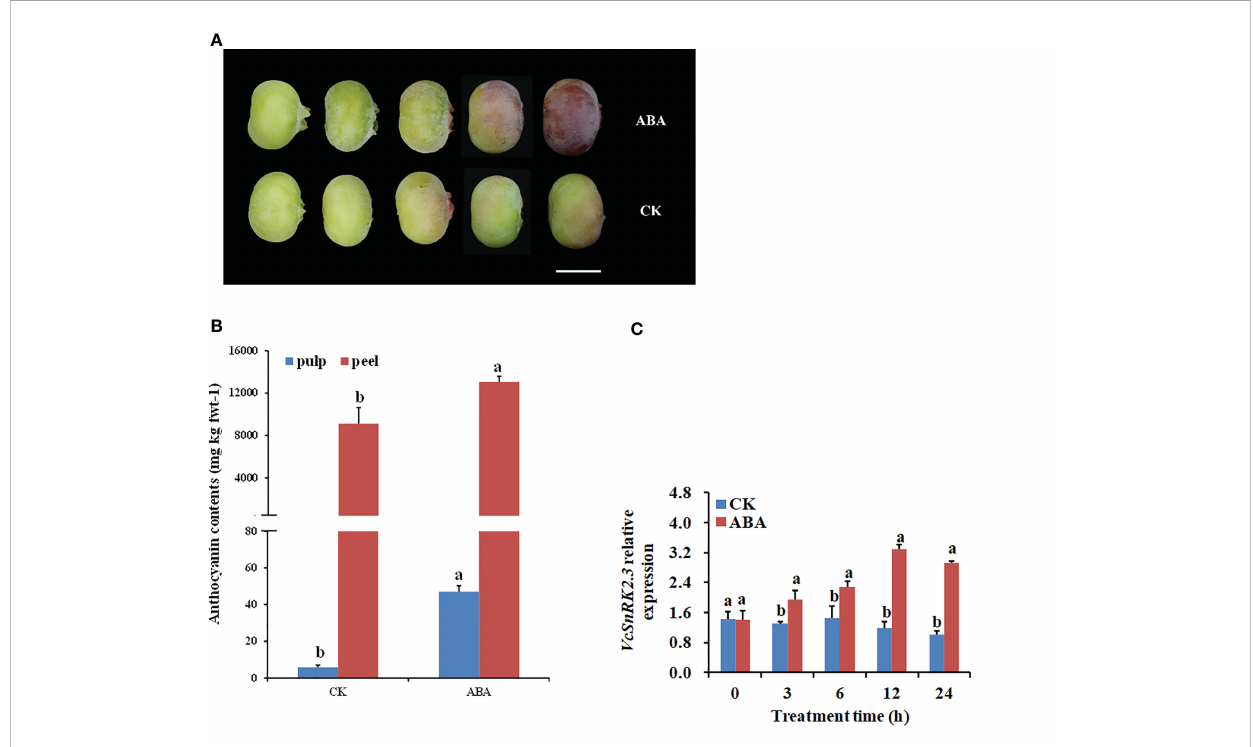
FIGURE 3 ABA and CK treatment in blueberry fruits. (A) Isolated blueberry fruits were treated with 100 m M ABA immersion at 0, 3, 6, 12, and 24 h. CK indicates the negative control (no treatment). Scale bar = 8 mm. (B) Anthocyanin contents of ripe blueberry fruits. Different letters above the bars indicate a signi fi cant difference based on a t-test ( P < 0.05). Values are the means + SD of three biological replicates. (C) qRT-PCR analysis of VcSnRK2.3 relative expression in blueberry fruits. Different letters above the bars indicate a signi fi cant difference based on a t-test ( P < 0.05). Values are the means + SD of three biological